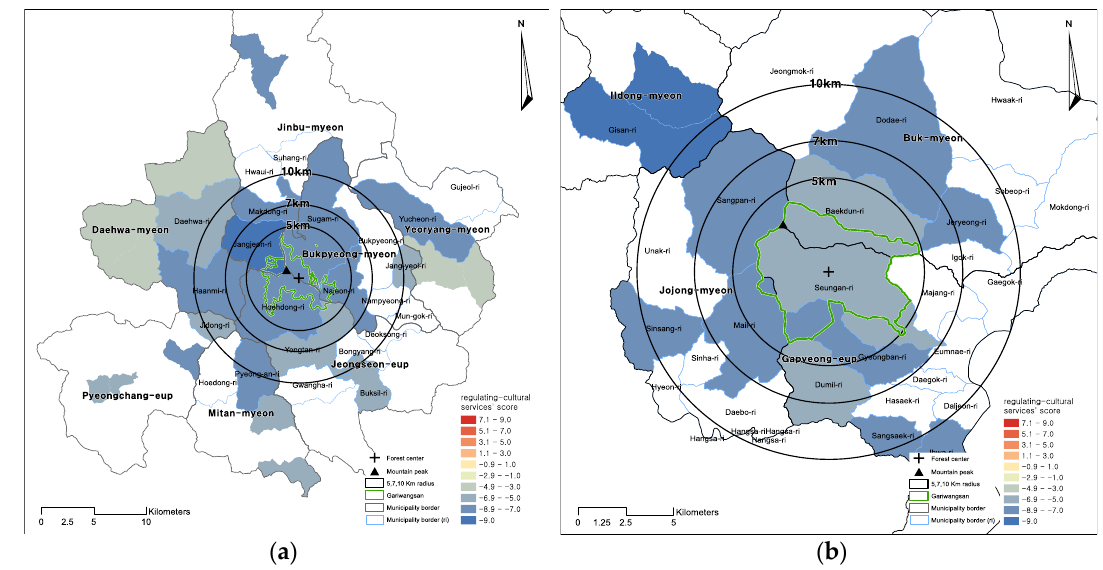
Figure 4. Score maps of competing ecosystem services (provisioning versus regulating ES categories) in ( a ) Gariwangsan and ( b ) Yeoninsan.